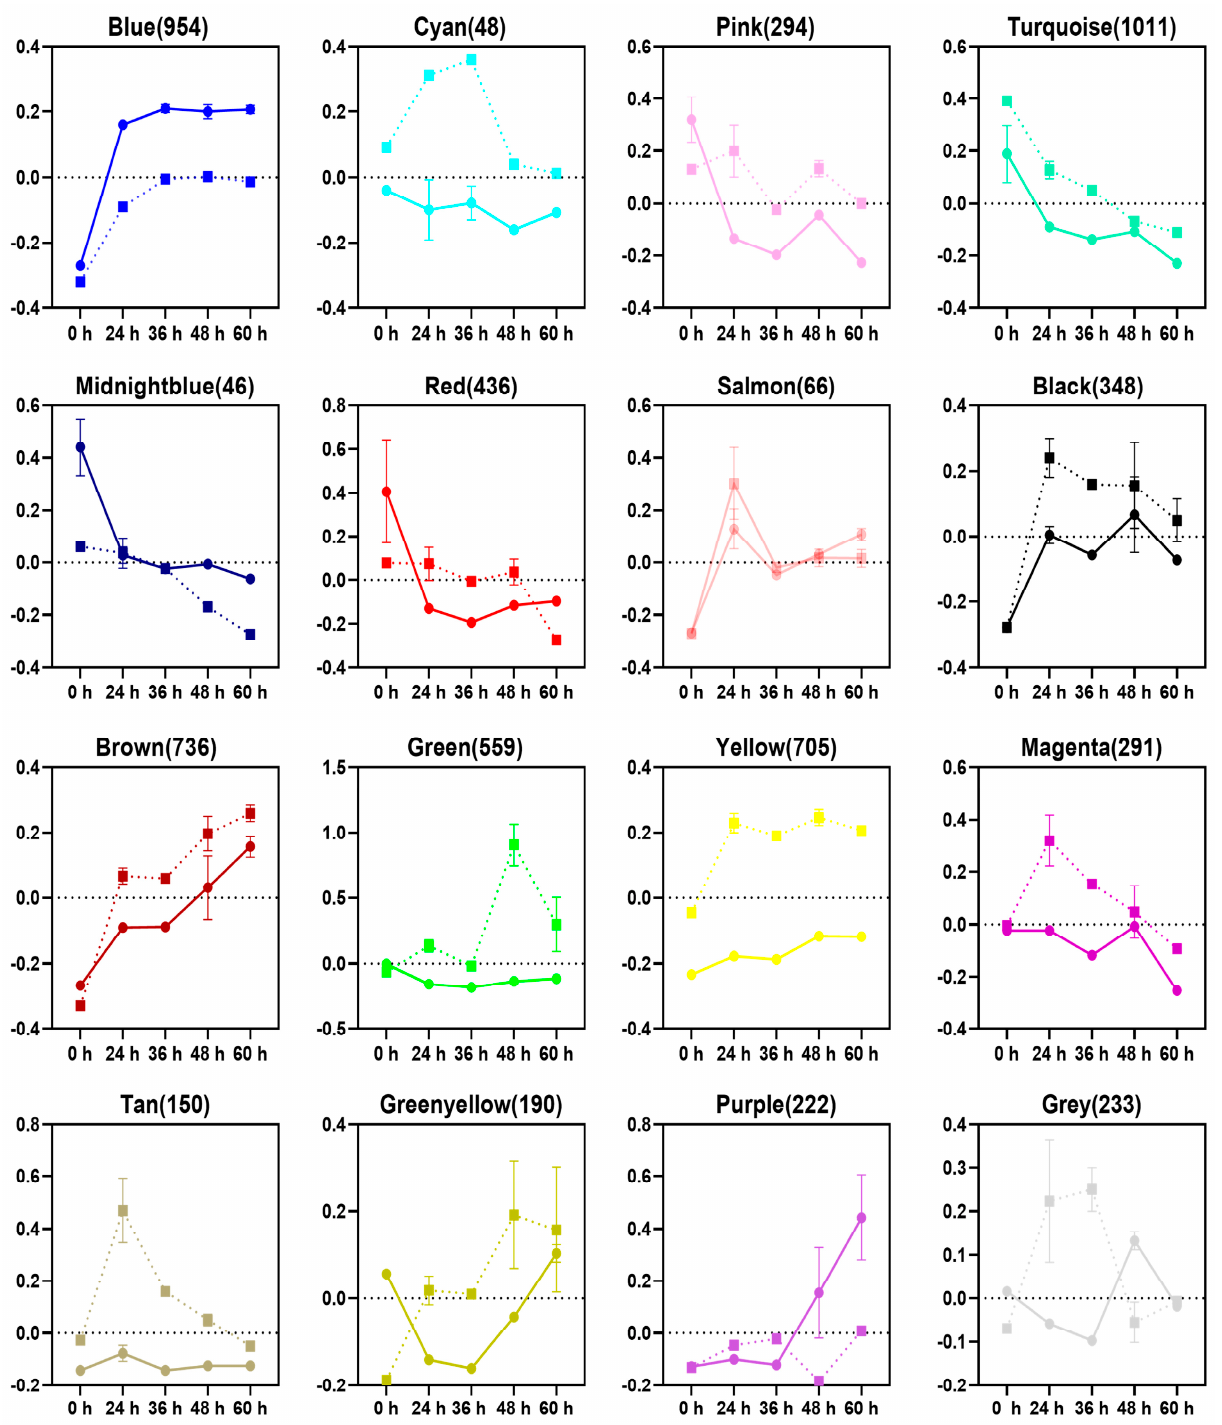
Figure 2. Expression profile of co-expression modules during the mating of U. esculenta . The RNA-seq expression data set was subjected to WGCNA to define co-expressed modules. Squares and dotted lines represent MT-type U. esculenta , and circles and solid lines represent T-type U. esculenta . The vertical axes indicate log 2 expression levels relative to the mean expression across all stages. Error bars indicate the standard deviation of three biological replicates. The horizontal axes indicate the stages, i.e., 0, 24, 36, 48, and 60 h post-incubation.